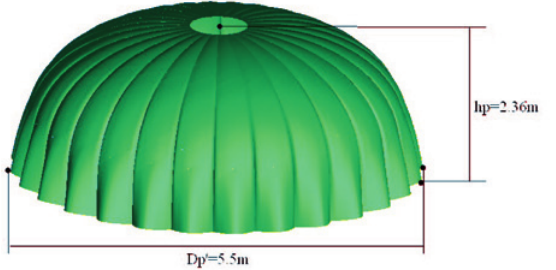
Fig. 11. Geometry a ft er processing